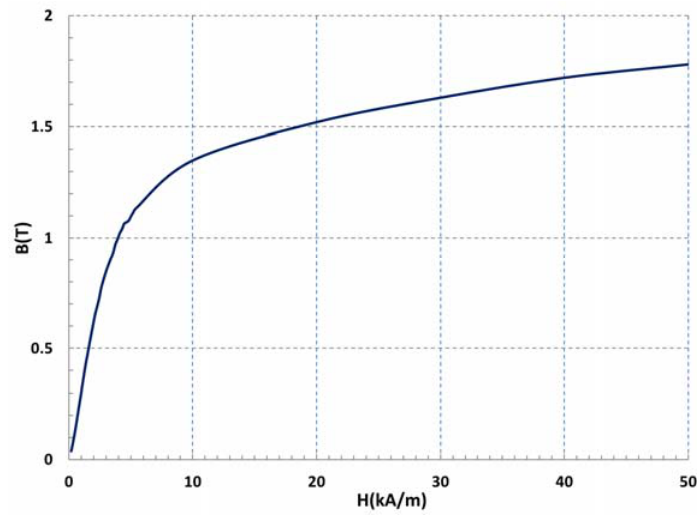
Figure 10. B ‐ H curve of the SMC used.